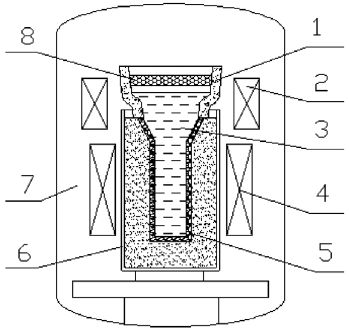
Fig. 1: Schematic of experimental apparatus. (1) Gate tile; (2) DC field generator; (3) molten; (4) AC rotating field generator; (5) shell;